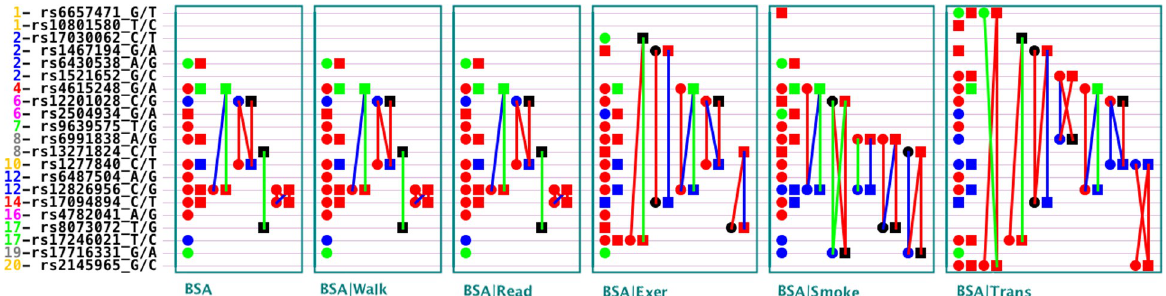
Fig 1. Genetic architecture of detected QTSs for Body Surface Area (BSA) in both base model and five cofactor models with experiment-wise significance ( − Log 10 P EW > 5). BSA: base model; BSA|Walk = walk cofactor model; BSA|Exer = exercise cofactor model; BSA|Read = read cofactor model; BSA|Smoke = smoke cofactor model; and BSA|Trans = transportation cofactor model. Note: The left axis is the QTS IDs: Chromosome-SNP-Alleles; Red circle dot: QTS with additive effects; Green circle dot: QTS with ethnic-specific additive effects; Blue circle dot: QTS with both additive and ethnic-specific additive effects; Red square dot: QTS with dominance effects; Green square dot: QTS with ethnic- specific dominance effects; Blue square dot: QTS with both dominance and ethnic-specific dominance effects; Line between two QTSs = epistasis effects; Red color = QTS with general effects for two race groups; Green color = QTS with ethnicity-specific effects; Blue color = QTS with both general and ethnicity-specific effects; Black color = QTS with ethnicity-specific effects but without detected individual effects.